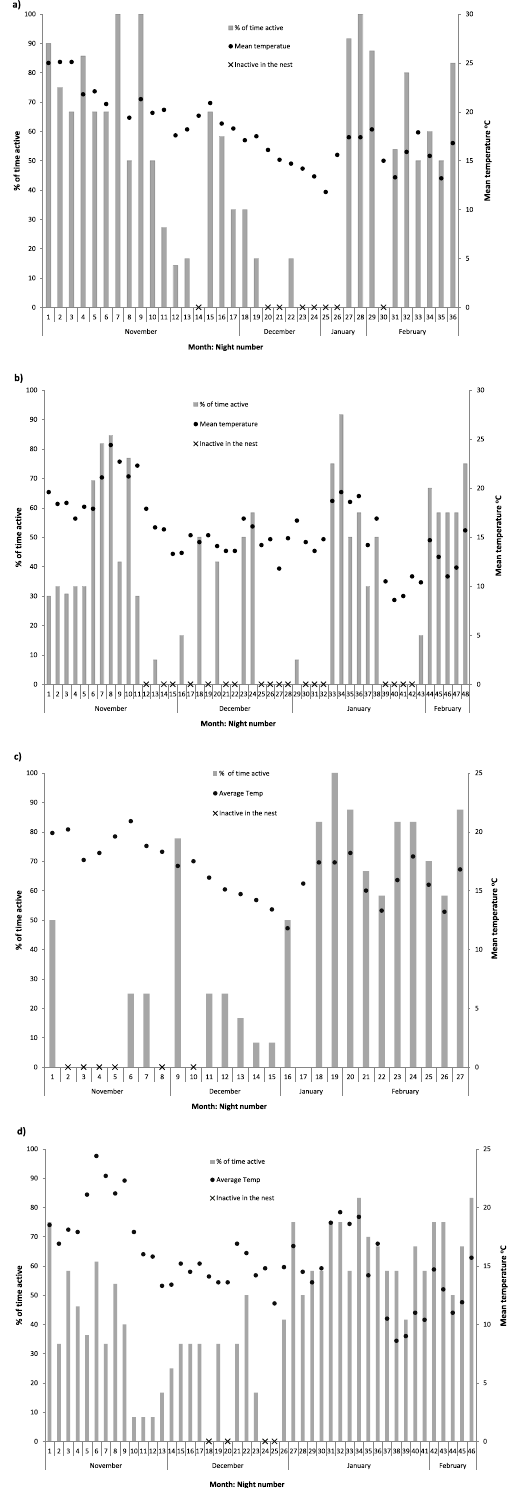
Figure 3. Activity data from four desert hedgehogs tracked over winter in Qatar; ( a ) hedgehog number 20 (female) tracked in 2010–2011, and hedgehog 116 (female) tracked in 2011–2012, ( c ) hedgehog number 60 (male) tracked in 2010–2011, and d) hedgehog 49 (male) tracked in 2011–2012. Grey bars show the percentage of radio-tracking fixes each hedgehog was recorded as active and outside of the nest on a given night, measured by radio-tracking signal and activity sensors. Black dots indicate the mean temperature that night. Black crosses indicate where hedgehogs were inactive and did not leave the nest all night. No bar indicates no tracking data for that